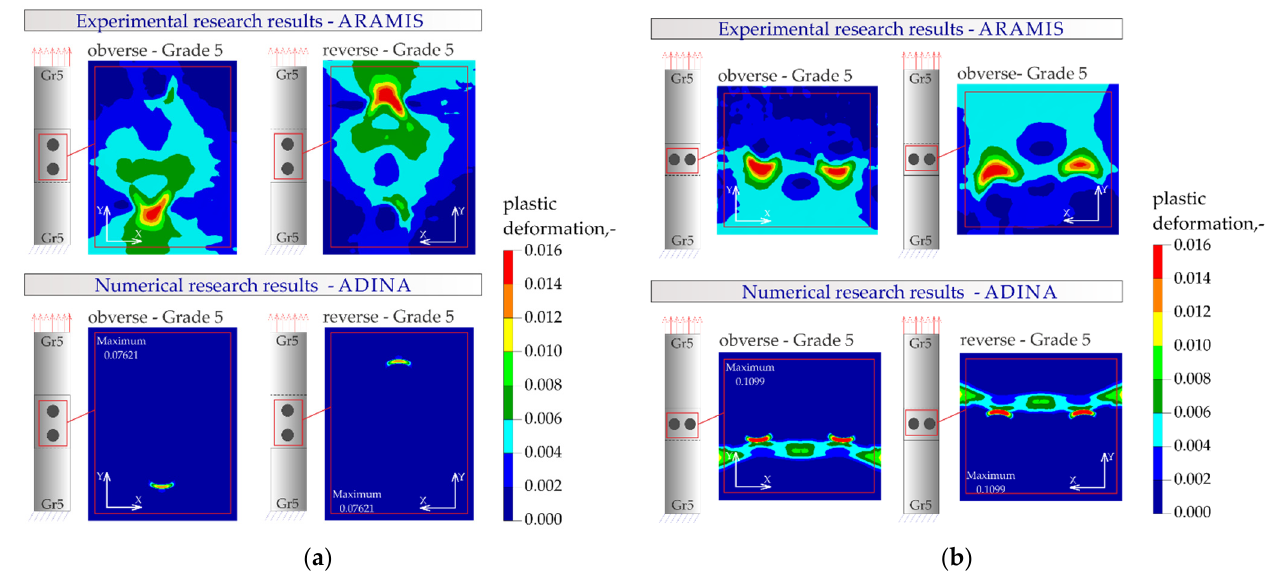
Figure 26. Distribution of plastic deformations: ( a ) in the joints with two welds arranged parallel to the direction of tensile shear—Gr5–Gr5.2 and ( b ) in the joints with two welds arranged perpendicular to the direction of tensile shear—Gr5–Gr5.3.